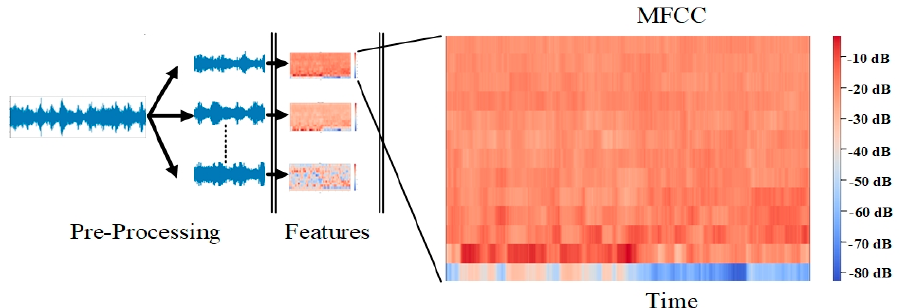
Figure 7. MFCC for a piece of blue class music .